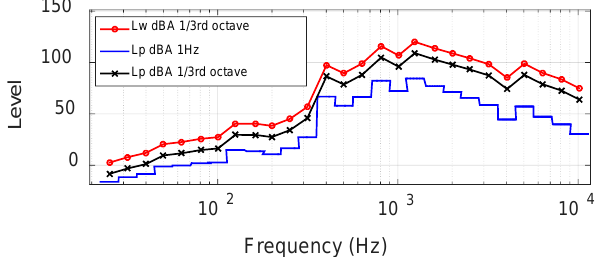
Figure 11. A-weighted sound power level (Lw), SPL ( Lp dBA 1/3 rd octave) equivalent spectra of a typical siren [40] at 1/3 rd octave frequency band and 1 Hz resolution band ( Lp dBA 1 Hz).